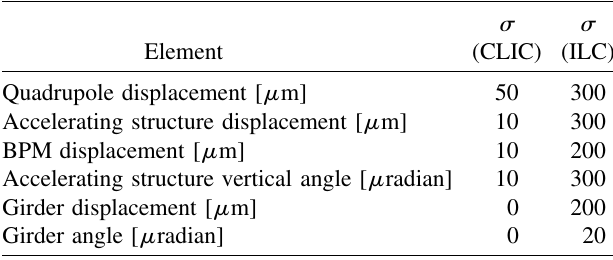
TABLE I. Root-mean-square element misalignments after pre-